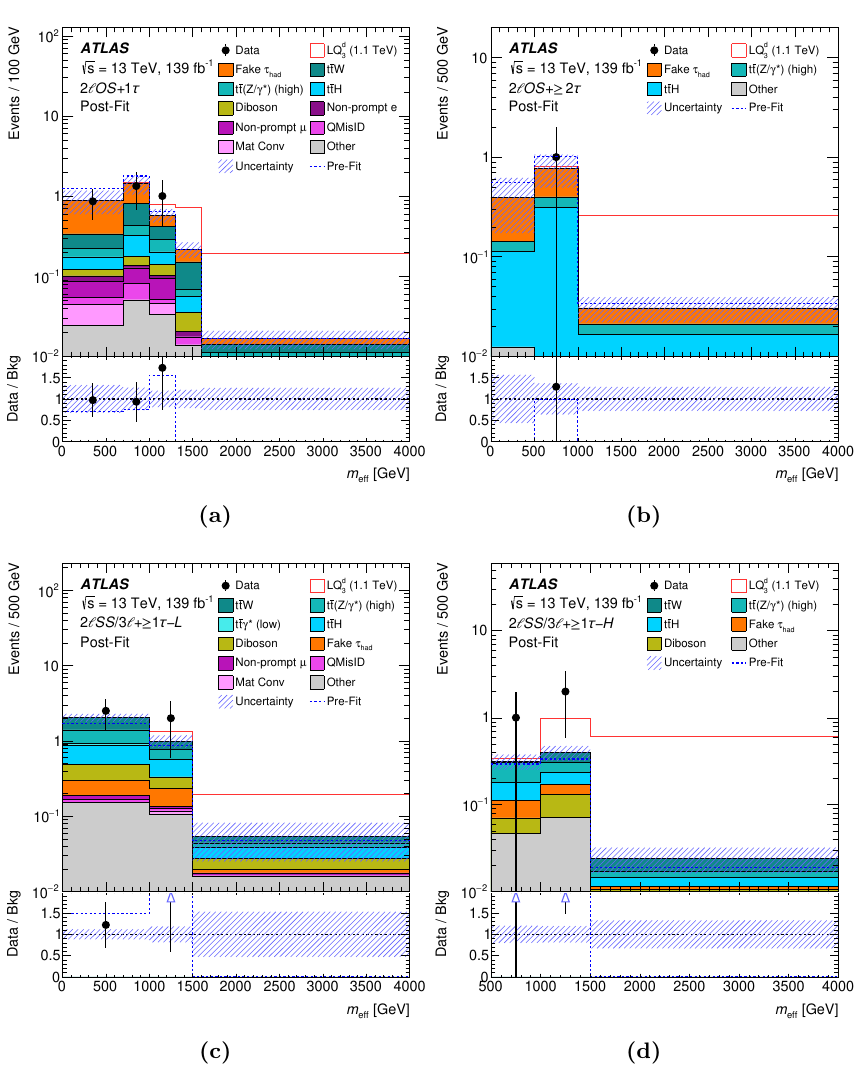
Figure 13. Comparison between data and prediction for the m eff distribution used in different signal region categories of the 2 ‘ OS+ ≥ 1 τ and 2 ‘ SS/ 3 ‘ + ≥ 1 τ channels: (a) 2 ‘ OS+1 τ , (b) 2 ‘ OS+ ≥ 2 τ , (c) 2 ‘ SS/ 3 ‘ + ≥ 1 τ -L, and (d) 2 ‘ SS/ 3 ‘ + ≥ 1 τ -H. The background contributions after the likelihood fit to data (“Post-Fit”) under the background-only hypothesis are shown as filled histograms. For illustrative purposes, the expected signal for m = 1 . 1 TeV and B = 1 is shown as unfilled red LQ d 3 histogram added to the post-fit background. The total background prediction before the likelihood fit to data (“Pre-Fit”) is shown as a dashed blue histogram in the upper panel. The ratio of the data to the background (“Bkg”) prediction is shown in the lower panel, separately for post-fit background (black points) and pre-fit background (dashed blue line). The size of the combined statistical and systematic uncertainty in the background prediction is indicated by the blue hatched band. The blue triangles indicate points that are outside the vertical range of the figure. The last bin in each figure contains the